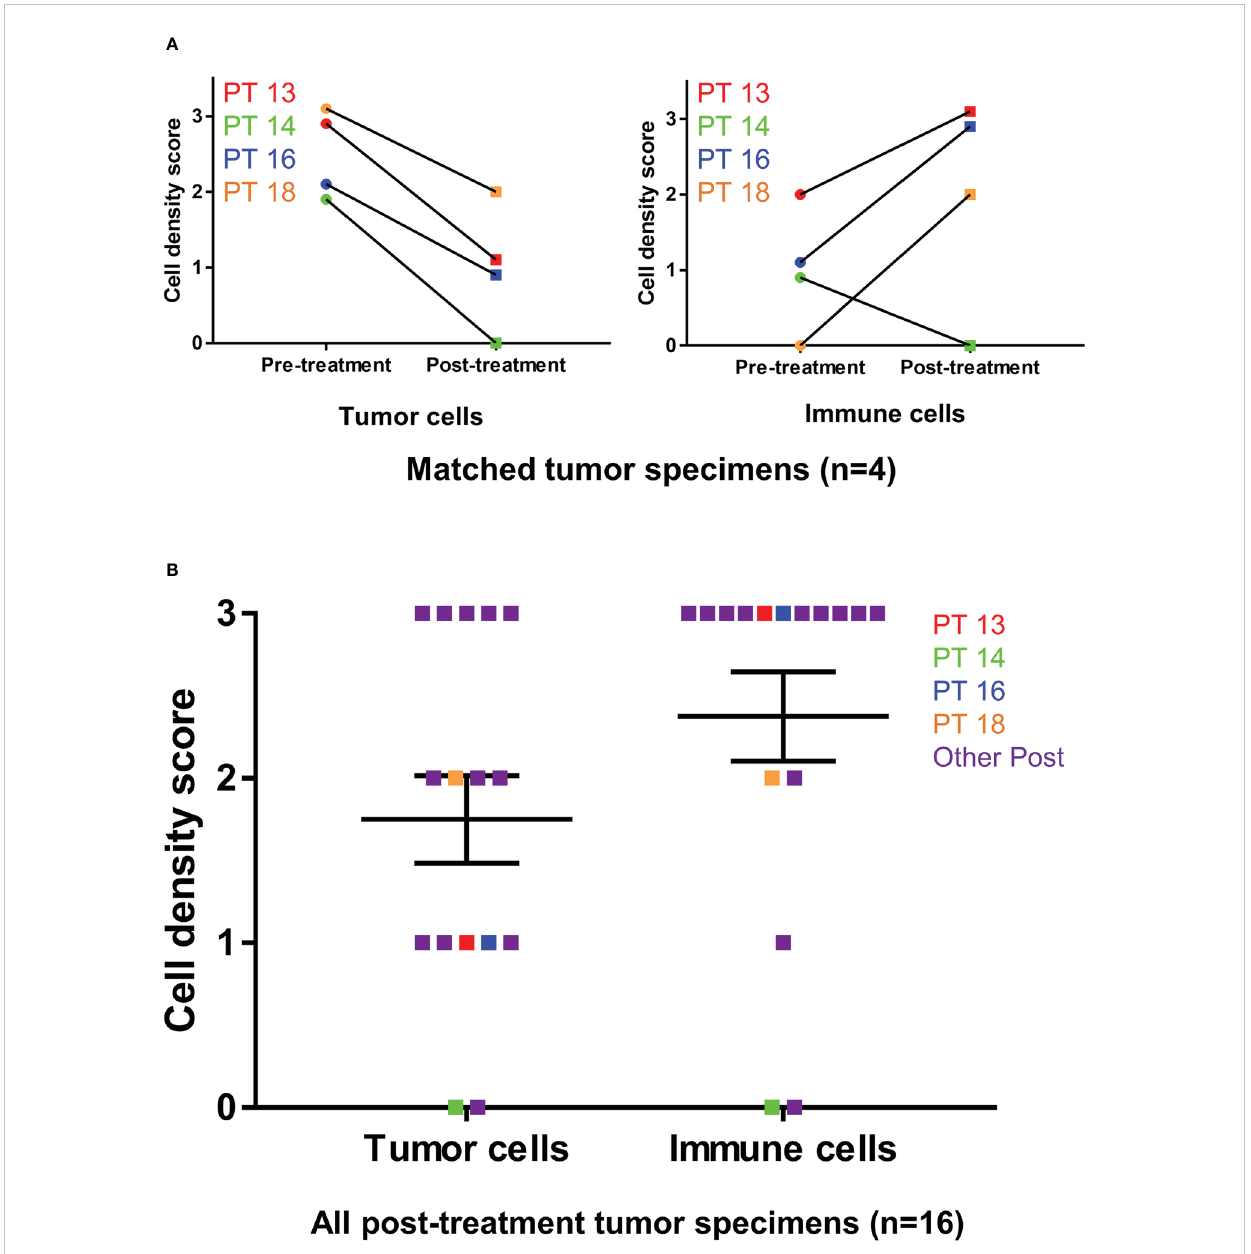
FIGURE 3 Tumor cell and immune cell density scoring before and after Olvi-vec therapy. (A) Matched MPM tumor sections obtained before and after Olvi-vec therapy underwent staining with hematoxylin and eosin and were scored for tumor cell density and immune cell density. (B) Tumor cell density scores and immune cell density were scored for all post-treatment tumor sections. Bars indicate mean and standard error of the mean